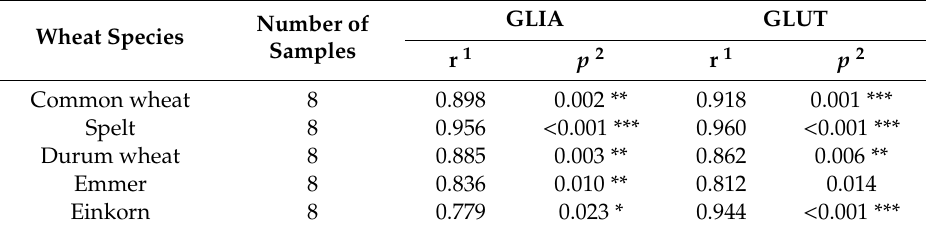
Correlation coe ffi cients (r) and levels of significance ( p ) between reversed-phase high-performance liquid chromatography (RP-HPLC) and Bradford assay for the quantitation of gliadins (GLIA) and glutenins (GLUT) in common wheat, spelt, durum wheat, emmer and einkorn. Number of Wheat Species Samples